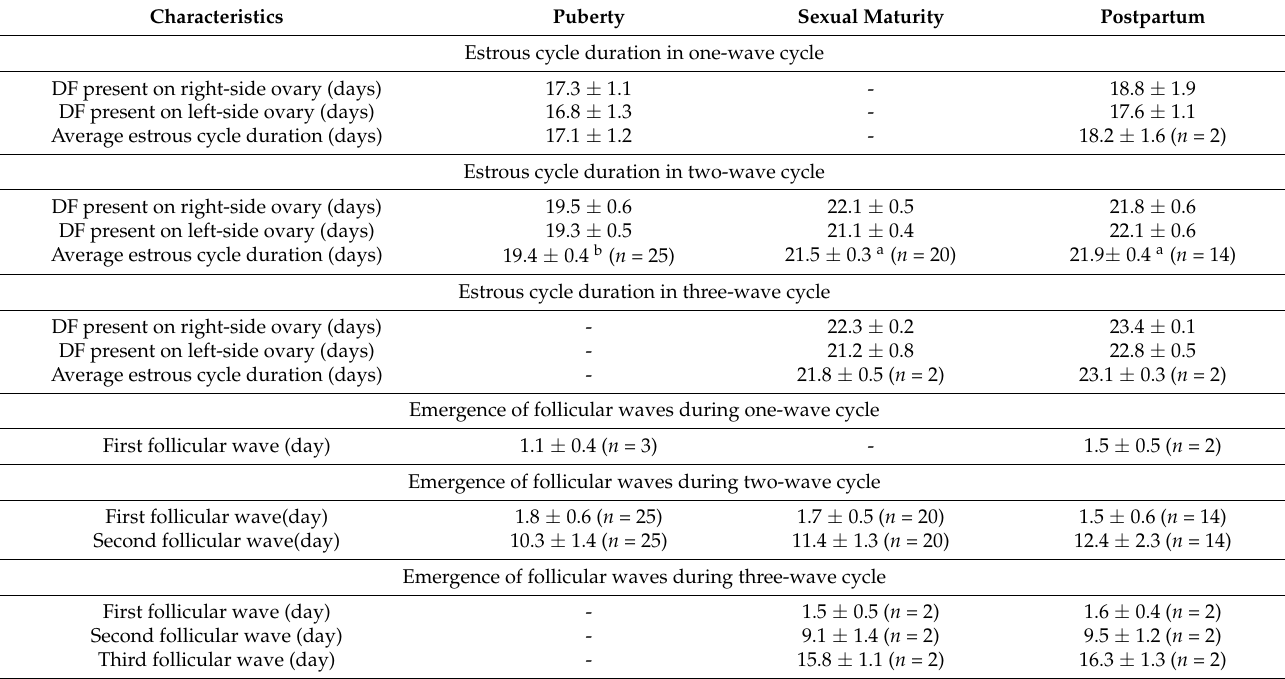
Table 2. Characteristics of estrous cycle of pubertal ( n = 28), mature ( n = 22) and postpartum ( n = 18) Chinese crossbred buffaloes.